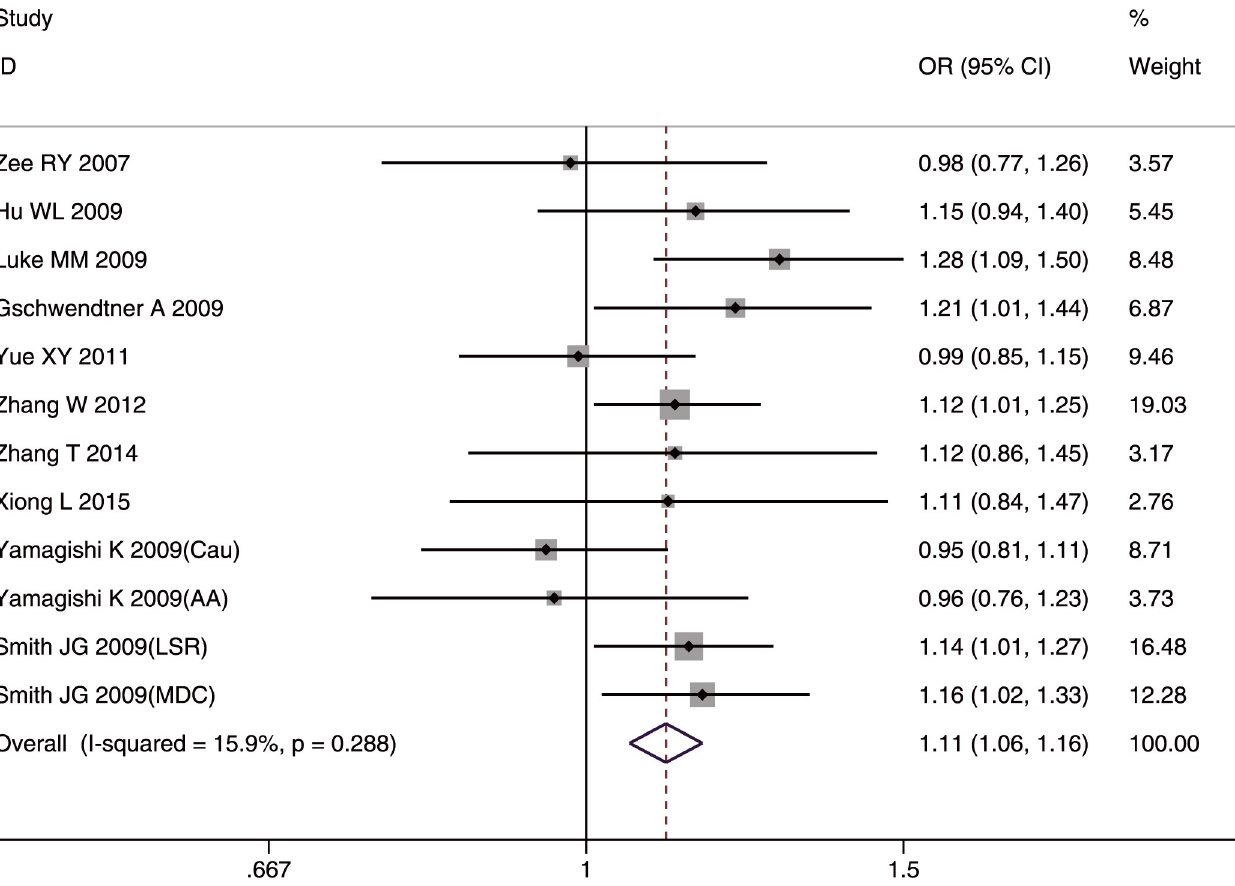
Fig 2. Forest plot of rs10757274 allele frequency (G vs. A) associated with IS in the whole studied population.